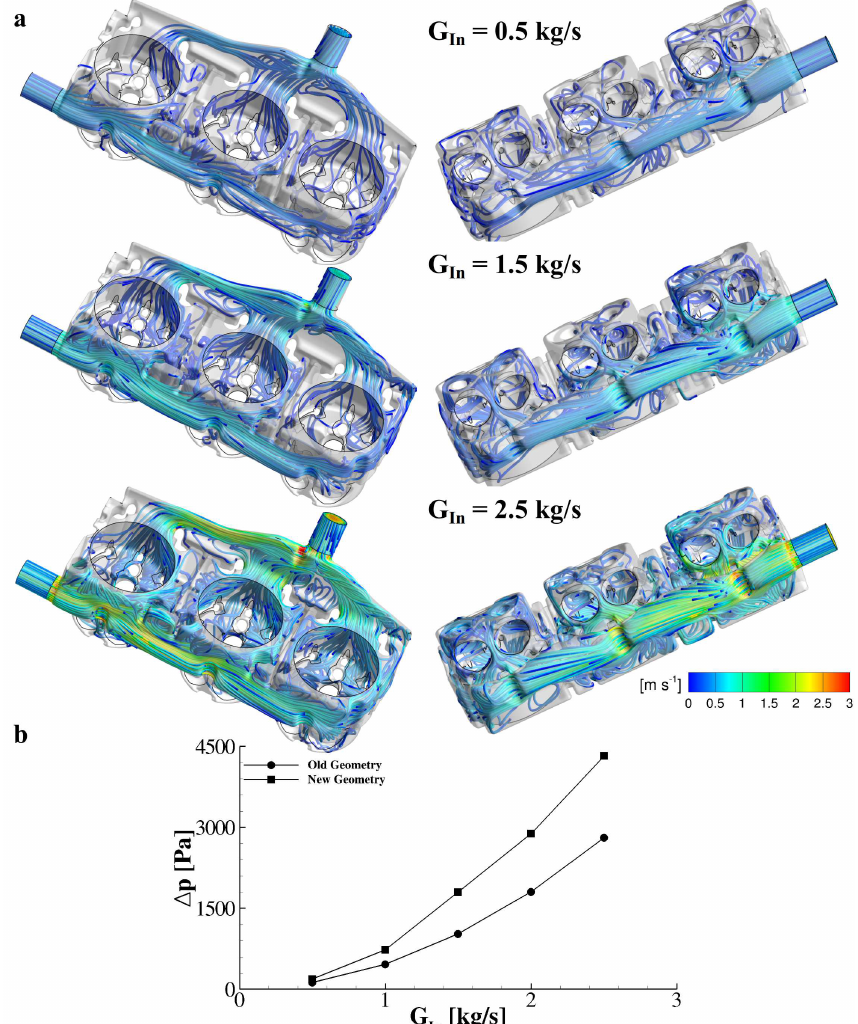
Figure 9. Velocity streamlines and characteristic loads for the new single-inlet geometry. ( a ) Velocity magnitude colored streamlines obtained for the new single-inlet geometry for G In = 0.5, 1.5 and 2.5 kg/s ( b ) Pressure loss as a function of the inlet mass-flow